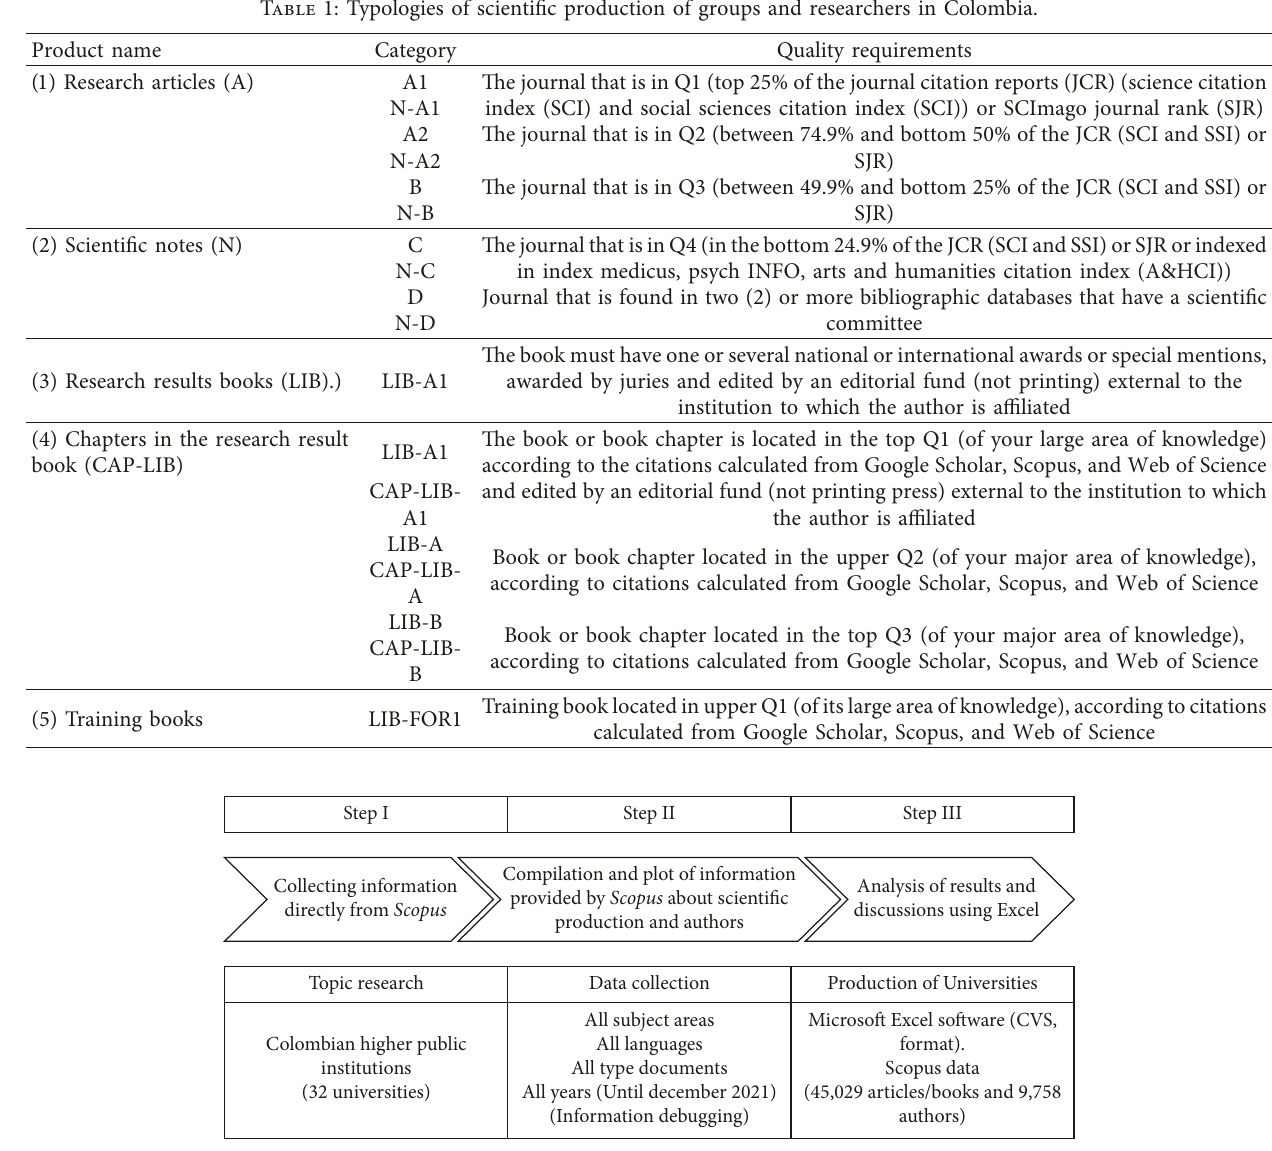
Figure 2: Methodology